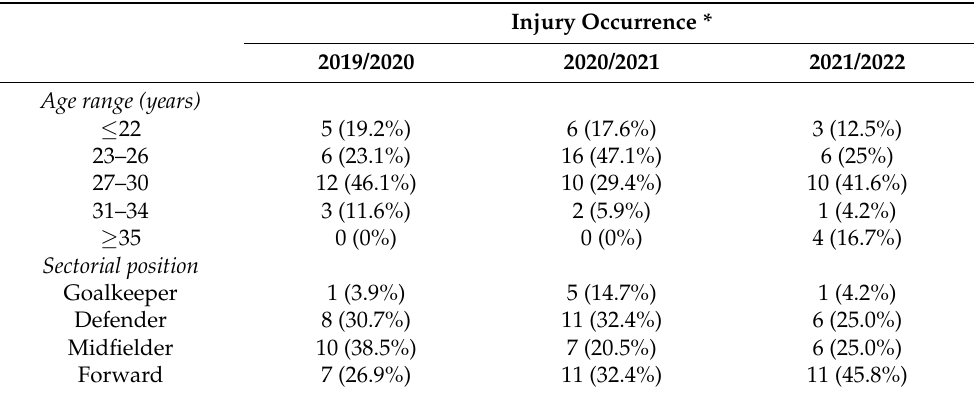
Table 3. Injury occurrence according to age and sectorial position during three consecutive sporting